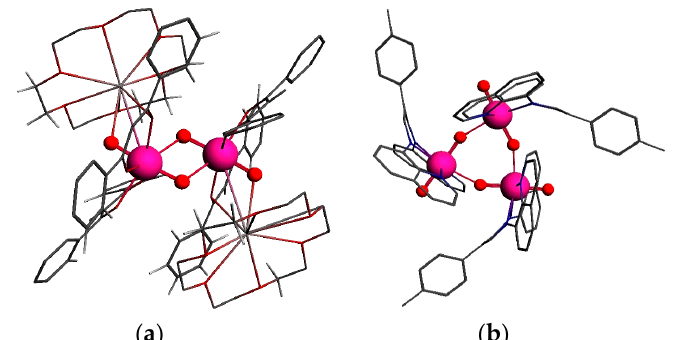
Figure 21. Optimized molecular structures of dioxo ( a ) [UO 2 (dbm) 2 K(18C6)] 2 and trioxo ( b ). [UO 2 (L)] 3 (L = 2(4-Tolyl)-1,3-bis(quinolyl)malondiiminate) Sticks used to depict C, N and K atoms; H atoms have been omitted for clarity. Pink and red colors respectively for uranium and oxygen atoms. (Unpublished results).